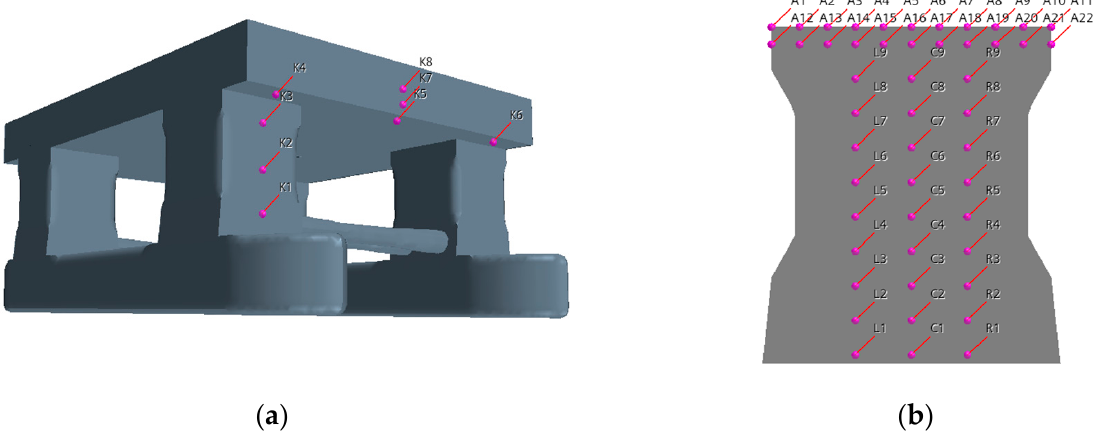
Figure 11. ( a ) Location of the slam-pressure monitoring points K1 to K8. ( b ) Location of the slam- pressure monitoring points A1 to A22, L1 to L9, C1 to C9 and R1 to R9.